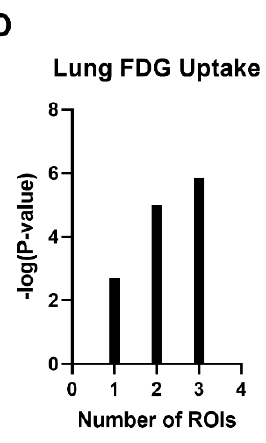
Figure 4. Correlation coefficient (A and C) and P-value (B and D) for the association between organ-specific FDG uptake measured using multiple manually selected ROIs and FDG uptake determined using deep learning-generated segmentation maps, as a function of number of manually selected ROIs, for the subcutaneous adipose tissue (A and B) and lungs (C and D). ROI: region of